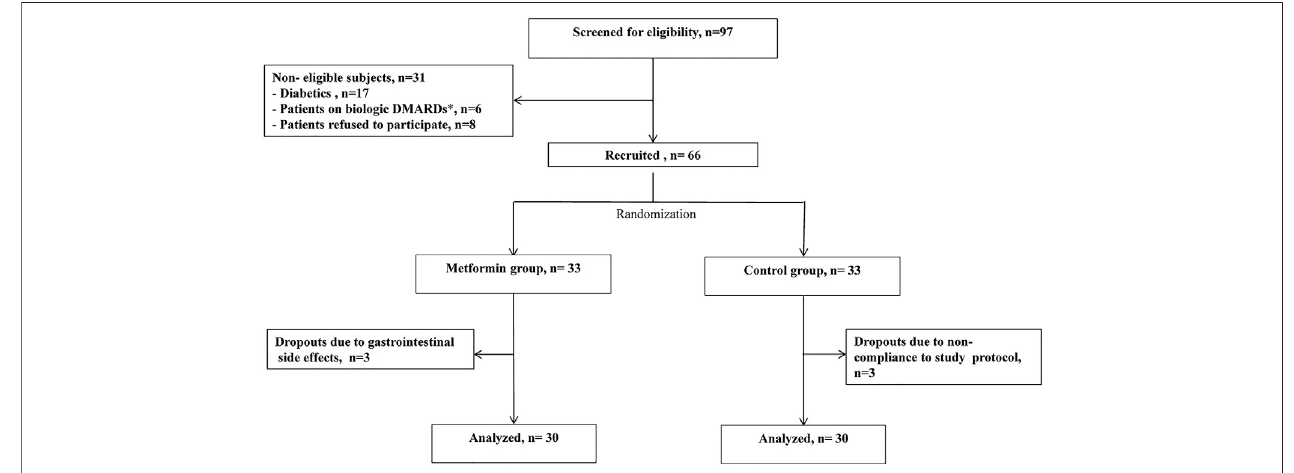
FIGURE 1 | The study fl ow chart. *DMARDs: disease modifying anti-rheumatic drugs.